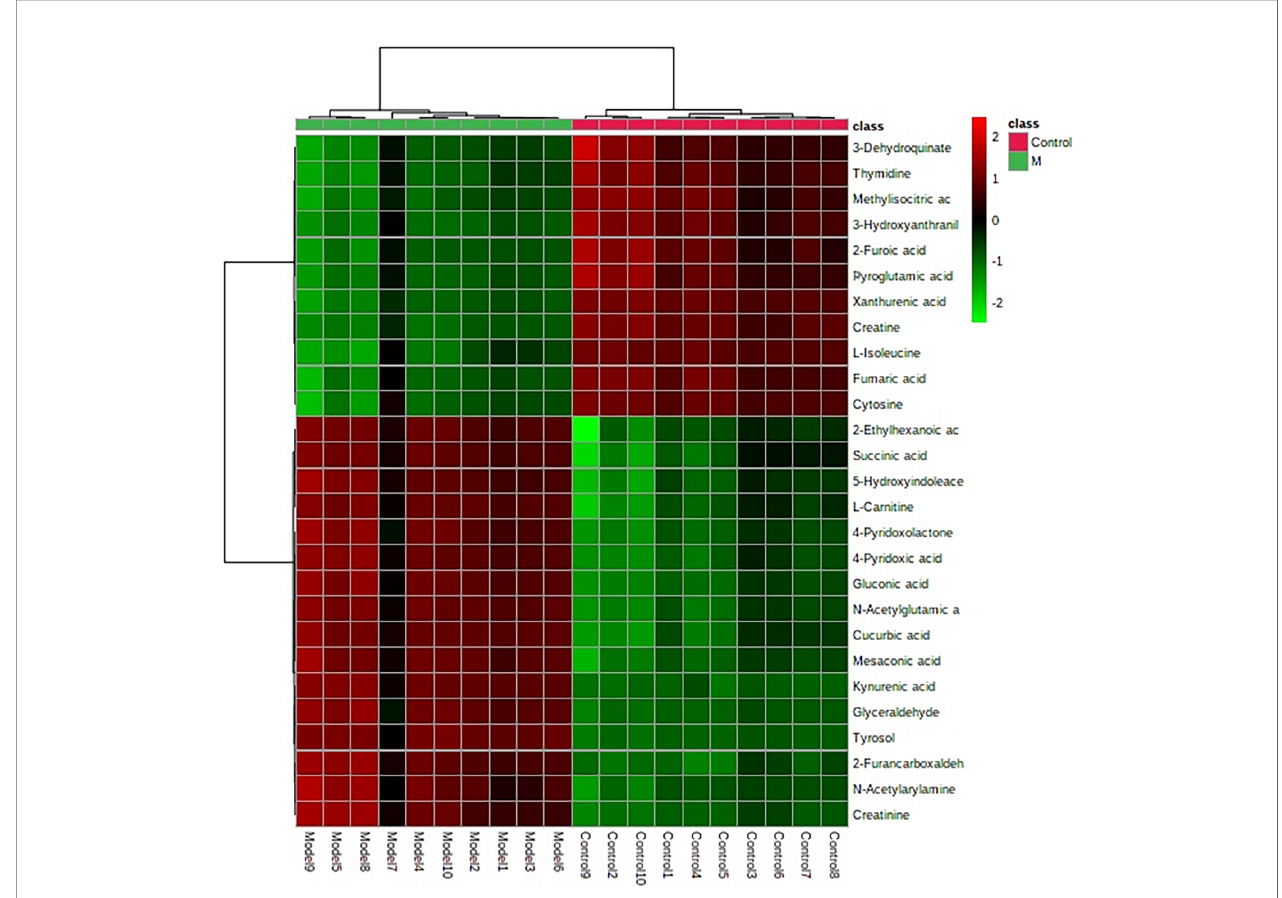
FIGURE 6 | Heatmap clustering for potential biomarkers in the control, and model groups. Individual samples are in columns. Samples are identi fi ed by the colored bars on the top. Clustering of the potential biomarkers was performed with the Ward algorithm based on Euclidean